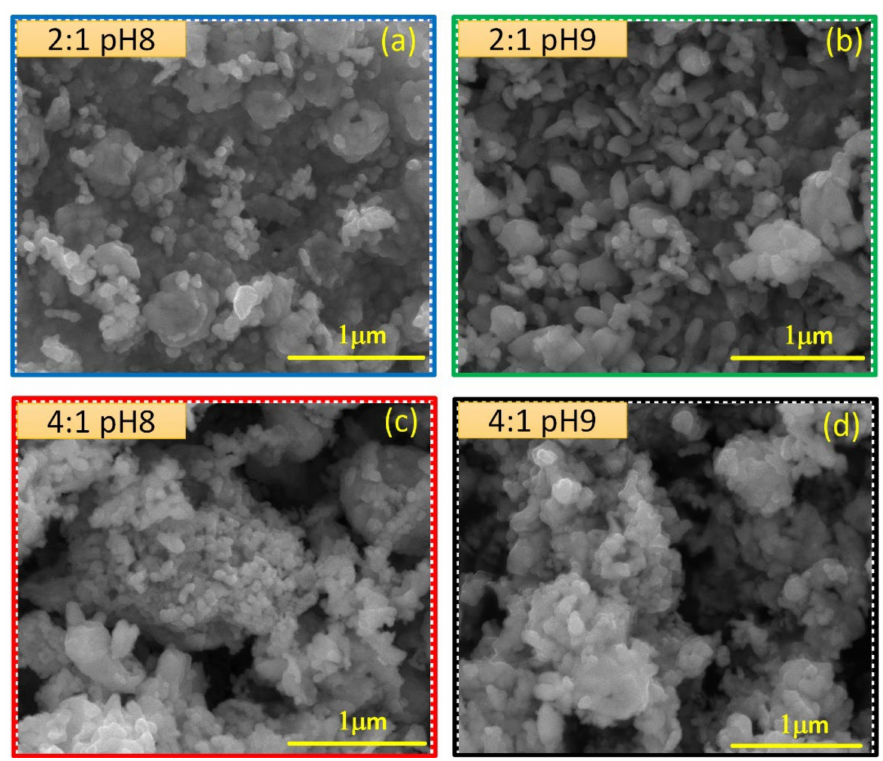
Figure 3. SEM images taken of CuO powders grown by following the ( a ) 2:1 pH8, ( b ) 2:1 pH9, ( c ) 4:1 pH8 and ( d ) 4:1 pH9 synthesis